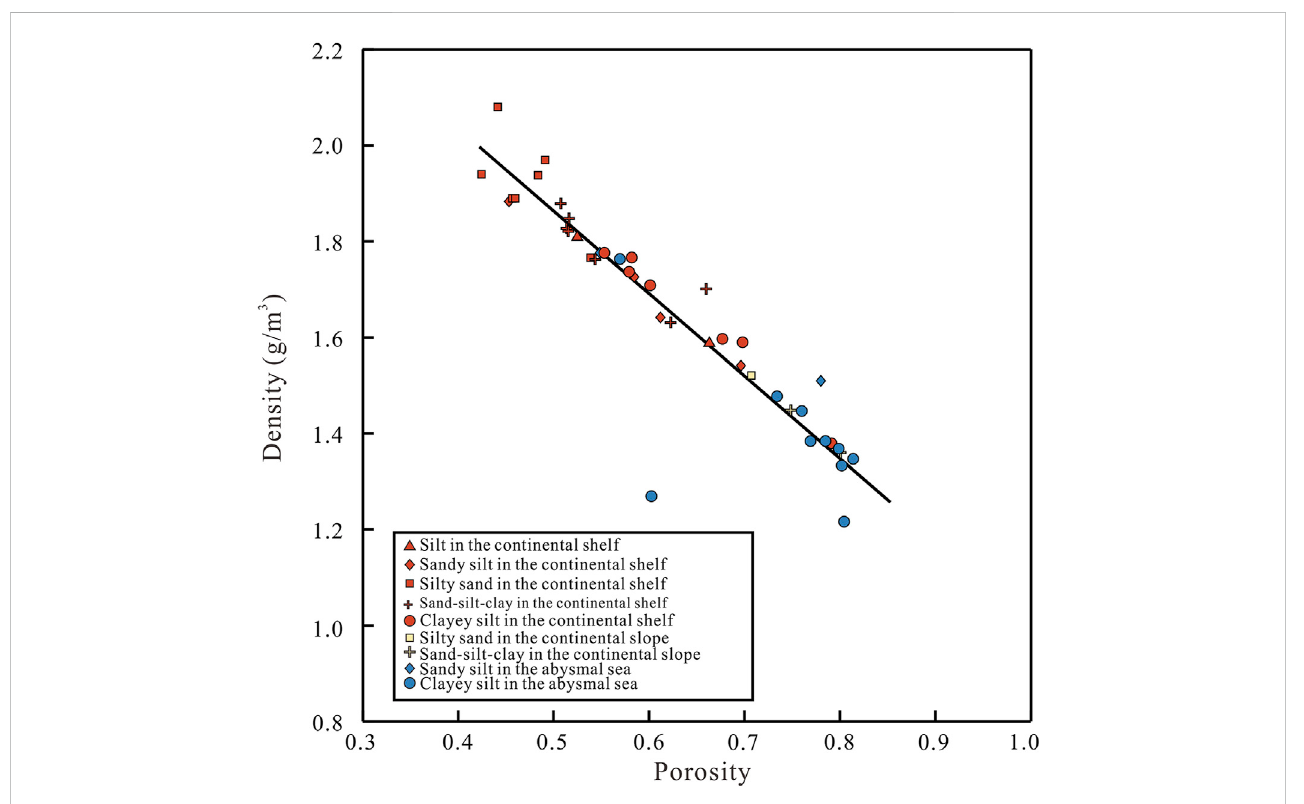
Relationship between the density and porosity of sea fl oor